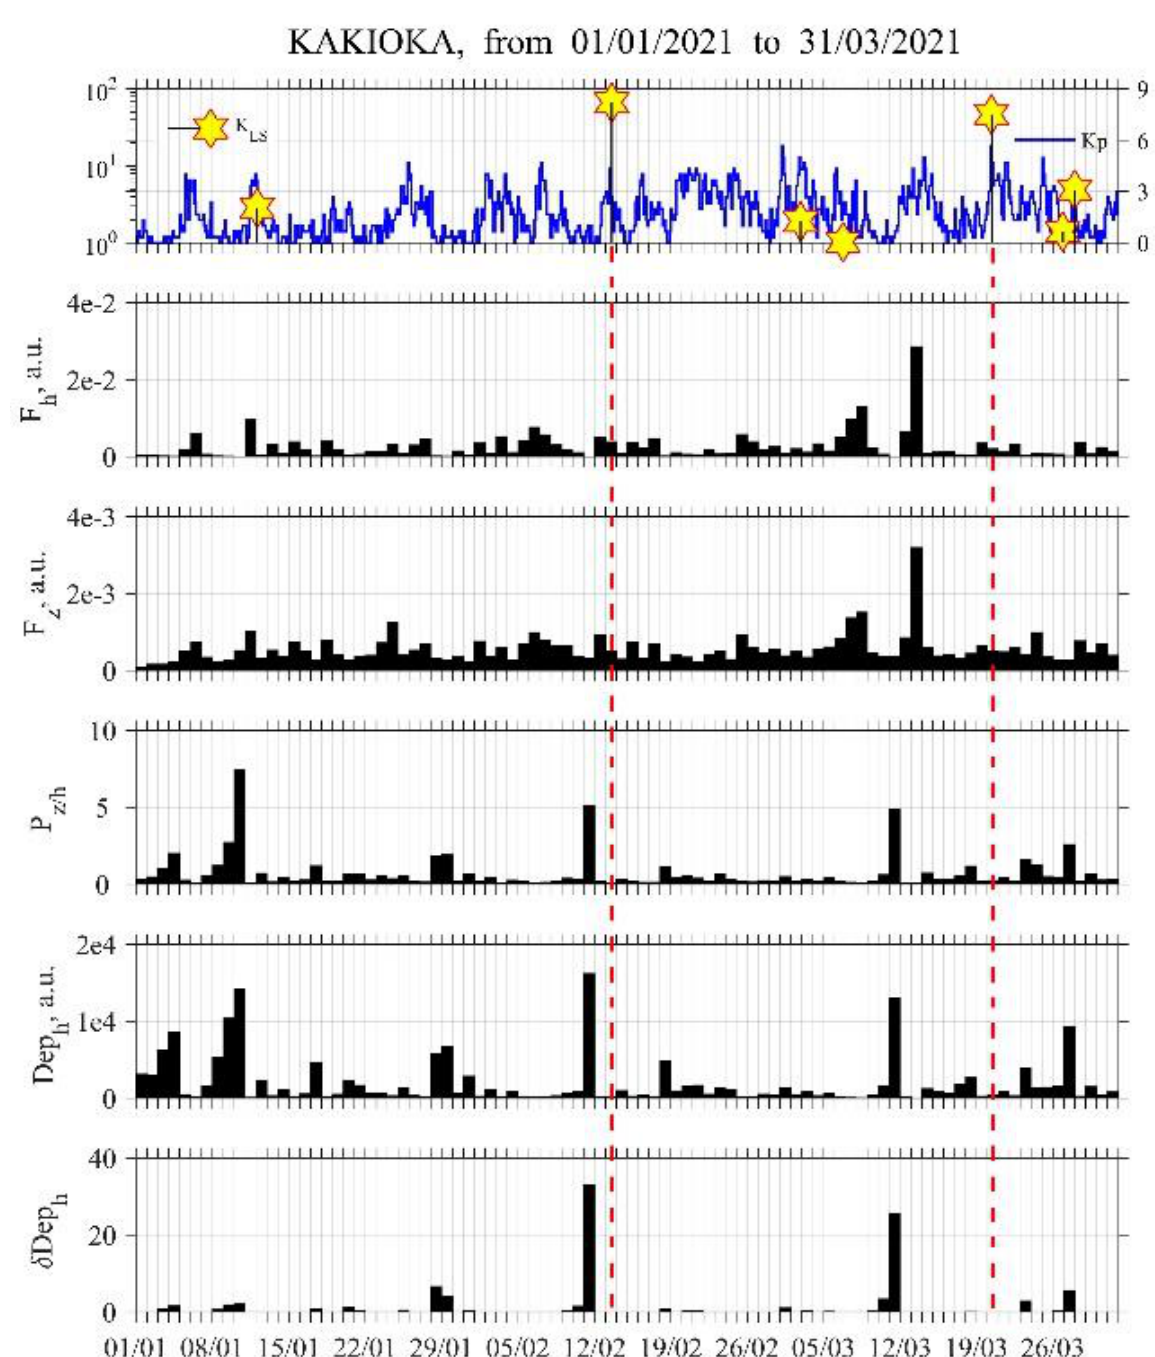
Figure 3. The evolution of seismicity, geomagnetic activity, and ULF magnetic field characteristics in the interval of 3 months from 1 January to 31 March 2021. The first two are represented on the top panel by the local seismicity index K LS and the geomagnetic activity Kp index. The average values of the horizontal Fh, vertical Fz component, and their ratio Pz/h are presented in the next three panels. Evolutions of depression Dep h and its variation δ Dep hi are depicted in the two bottom panels. The vertical red broken lines indicate the occurrence times of the two EQs.